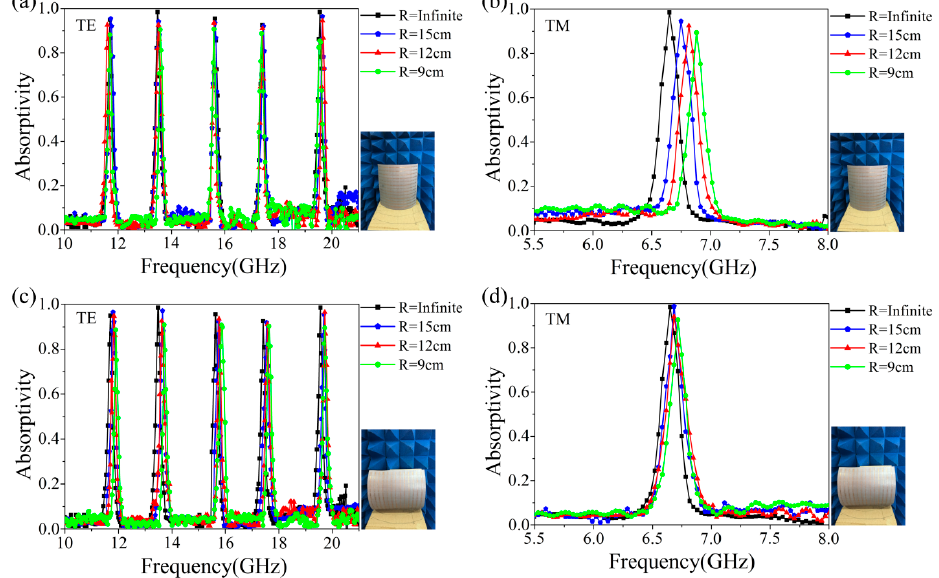
Figure 7. The measured absorptivity under different bent situations. ( a ) and ( b ) along the X axis; ( c ) and ( d ) along the Y axis.